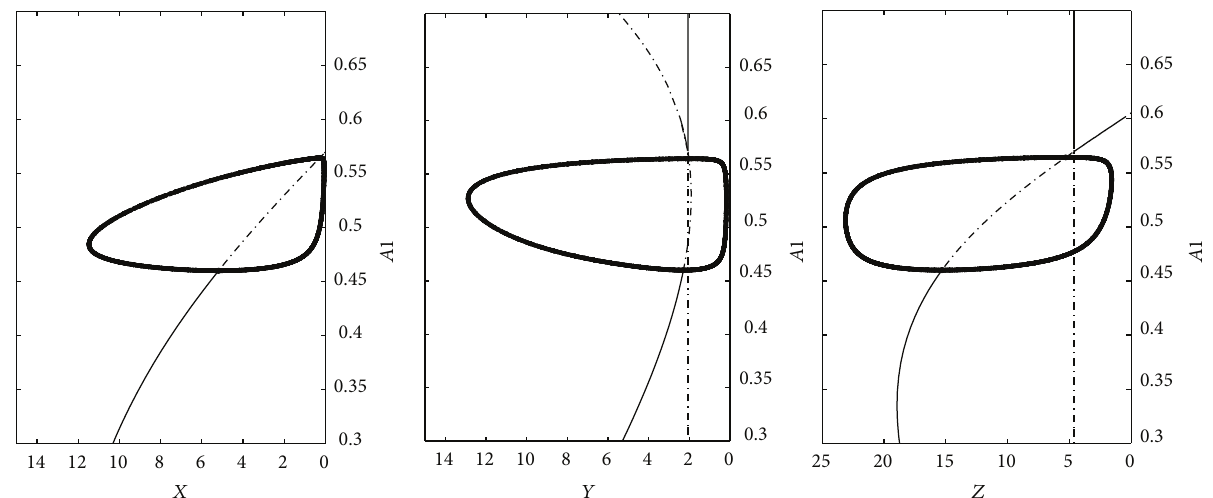
Figure 1: Bifurcation diagram of system (1) for 0.3 < 𝛼 1 < 0.7 , where 𝑋 = 𝑥 1 , 𝑌 = 𝑥 2 , 𝑍 = 𝑦 , and 𝐴1 = 𝛼 1 and the initial value 𝑥 1 = 1.3; 𝑥 2 = 1.5 ; and 𝑦 = 5 with parameters as follows: 𝑎 = 0.85 , 𝑊 = 0.75 , and 𝑑 = 0.25 . 0.55 , 𝑊 1 2